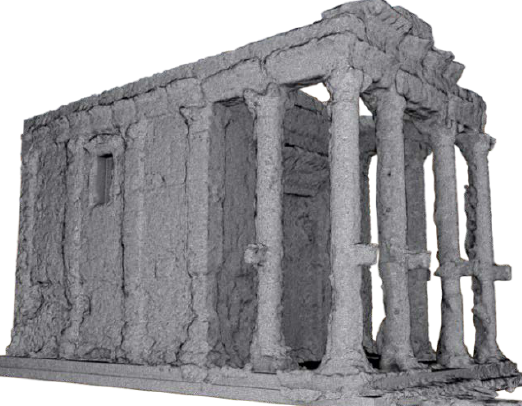
Figure 5. The 3d model mesh of the Baalshamin Temple using dense multi-view 3d reconstruction from tourist